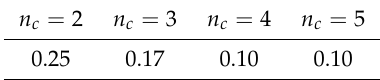
Table 2. Error rate in navigation after n c